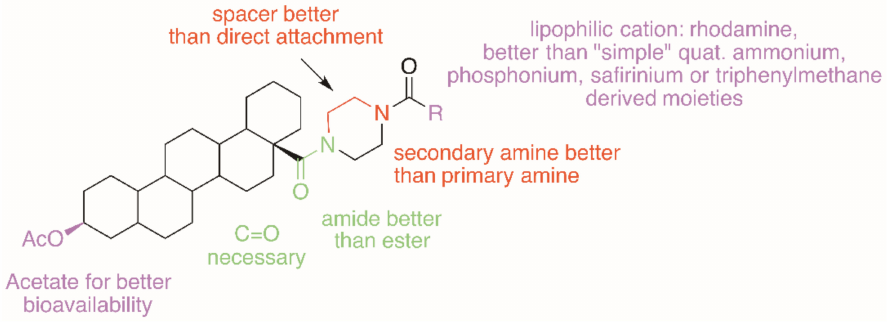
Figure 3. Hitherto known SAR parameters for obtaining pentacyclic triterpenoids of high